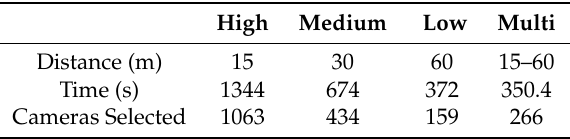
Table 4. Computational time and number of photos needed to model the entire Tibble Fork Dam at varying priority levels.